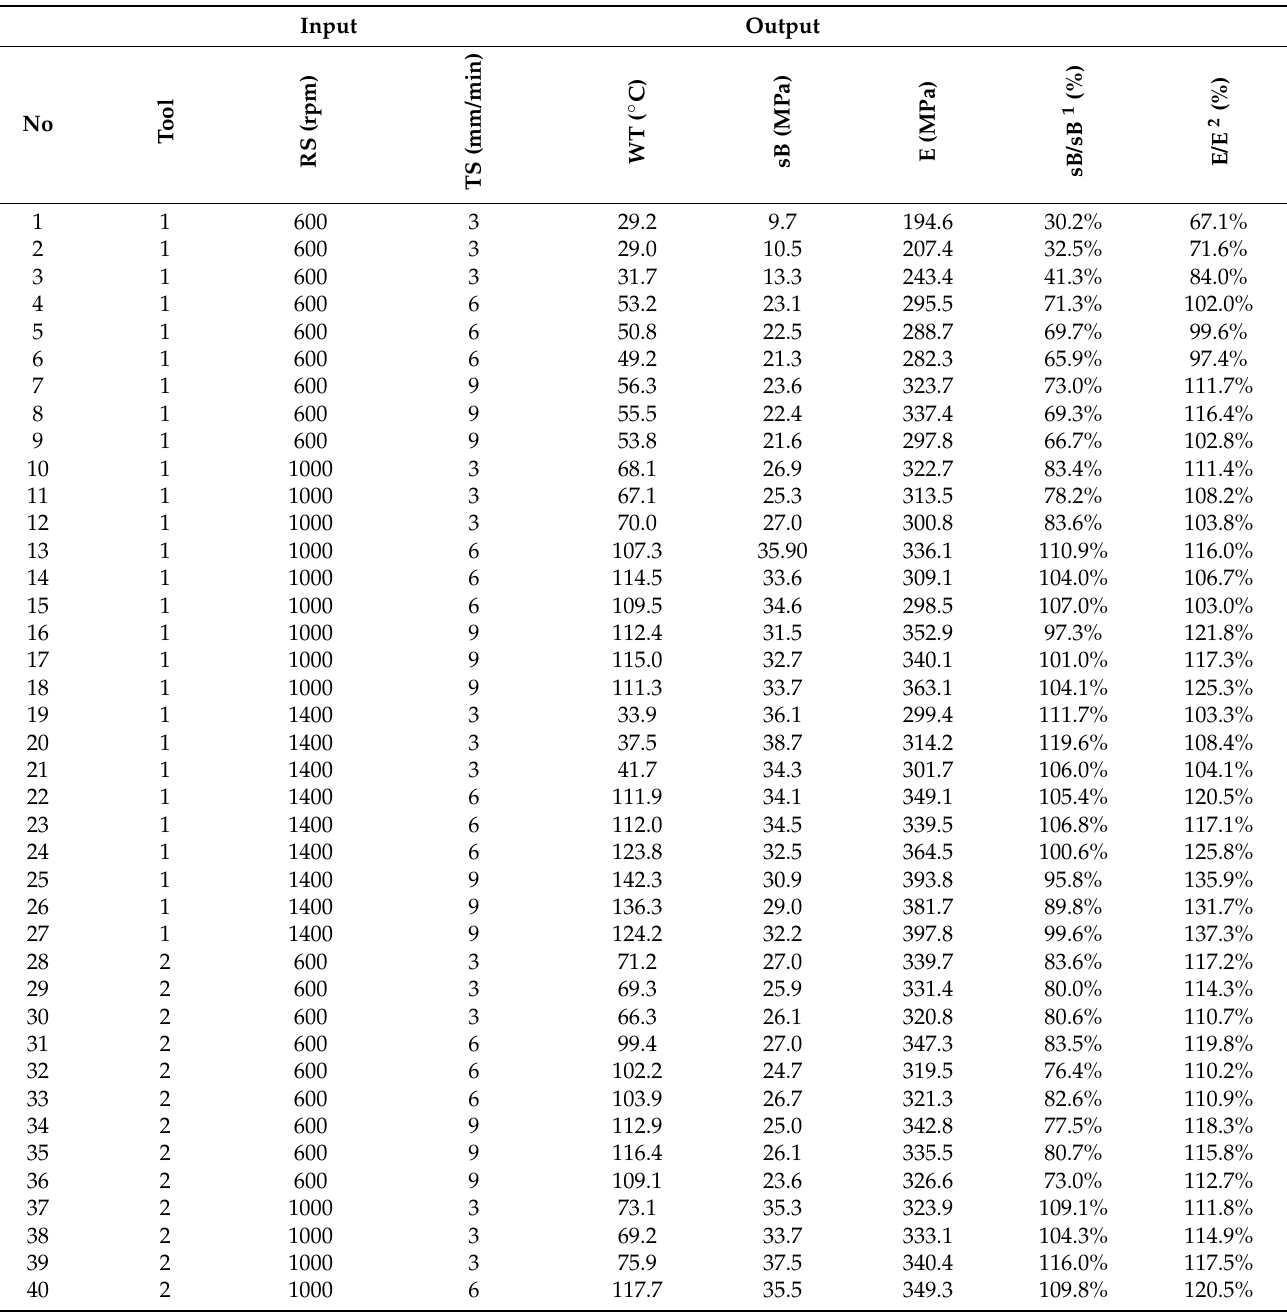
Table 2. Experimental